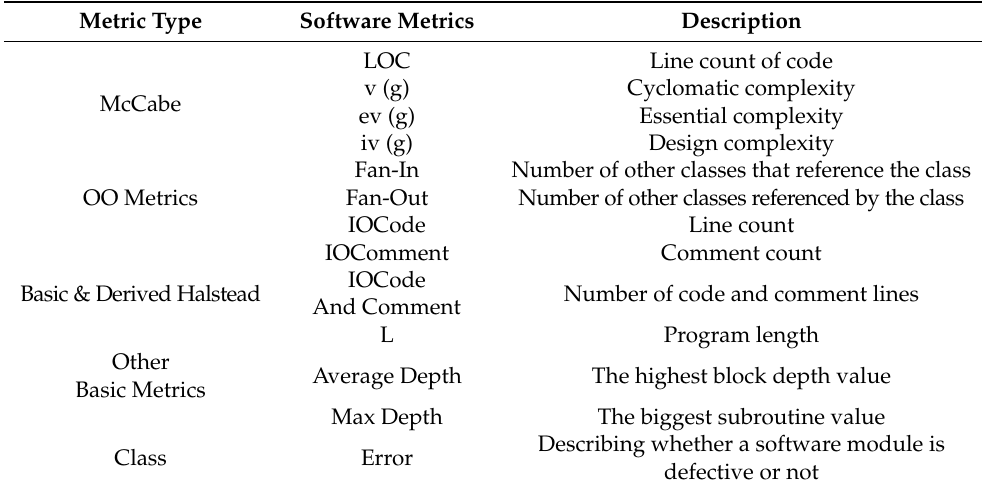
Table 4. Description of SFP XP-TDD software metrics.